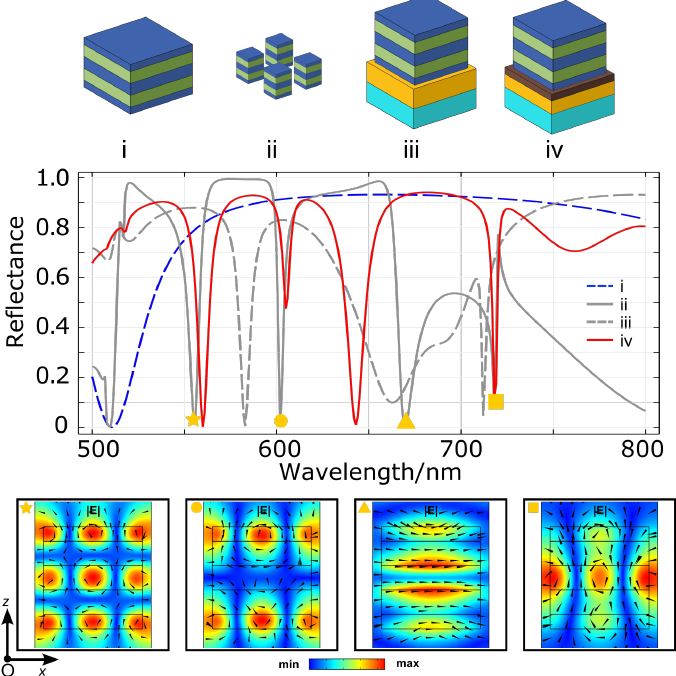
Figure 3. Reflectance spectra of different geometries denoted as (i) a free-standing dielectric multilayer stack with the same parameters as the dielectric cavity, (ii) a free-standing dielectric cavity array identical to DCIM top layer, (iii) DCIM MM without Al 2 O 3 spacer, and (iv) the DCIM MM absorber. The color indicator for each material is identical to Figure 1a. 2D color maps of electric field norm (| E |) distribution in xOz plane of the sample (ii) at different resonance wavelengths labeled with geometrical markers are presented at the bottom. The arrows denote corresponding magnetic field